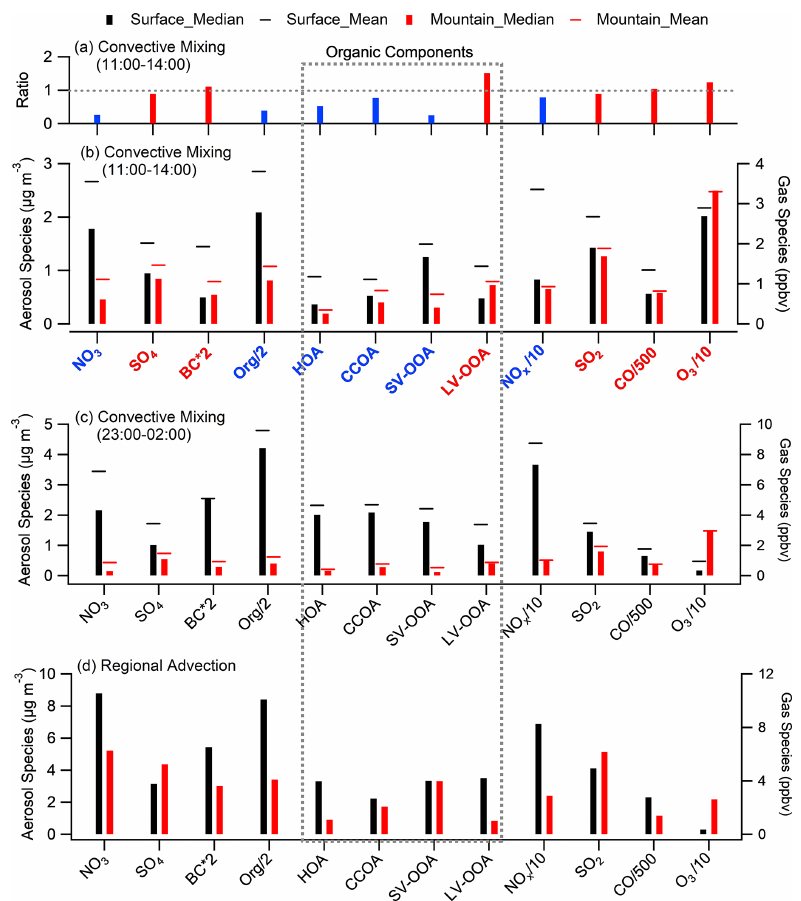
Figure 4. Statistical analysis of chemical components at both sites. (a) The mountain over surface ratio of key species during convective mixing (CM) daytime period (11:00–14:00). (b) Median concentrations of key species during CM daytime, with black and red bars denoting the surface and mountain, respectively, and the cap showing the mean. (c–d) The same as panel (b) but for the periods of CM night and the RA period. Species with a mountain/surface ratio above and below 0.8 (the transport efficiency for BC and CO) are marked in red and blue,